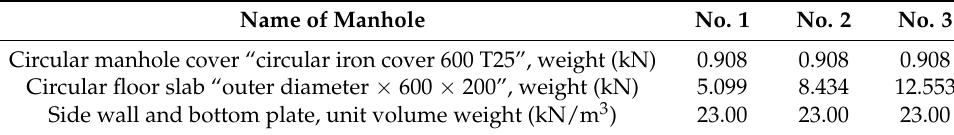
Table 2. Assumed conditions for manhole.